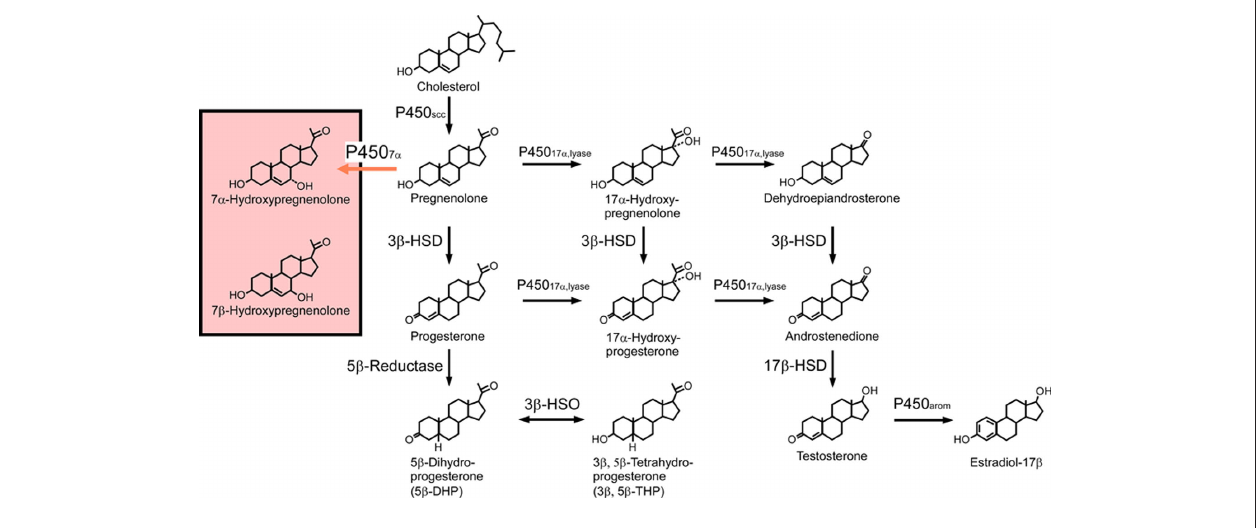
FigurE 1 | Biosynthetic pathways for neurosteroids in the quail brain. The black arrows indicate the biosynthetic pathways of neurosteroids identified previously in the quail brain. The red arrow indicates a newly identified biosynthetic pathway resulting in the biosynthesis of